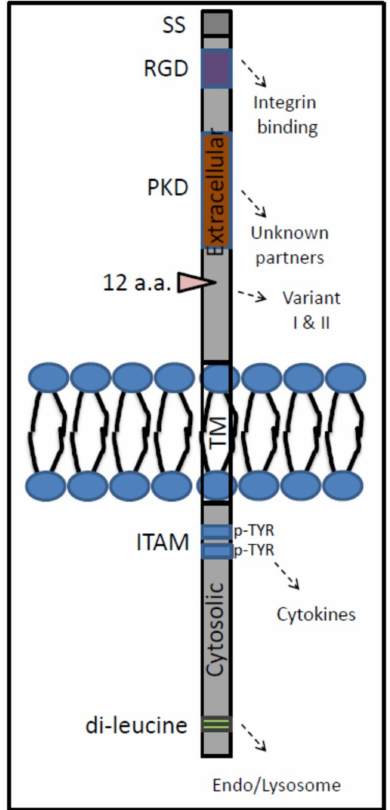
Figure 1. Schematic overview of Gpnmb protein. SS, signal sequence; RGD, RGD tripeptide; PKD, Polycystic kidney disease domain; a.a., amino acid; ADAM; a disintegrin and metalloproteinase; ITAM, immunoreceptor tyrosine-based activation-like motif; TM, transmembrane